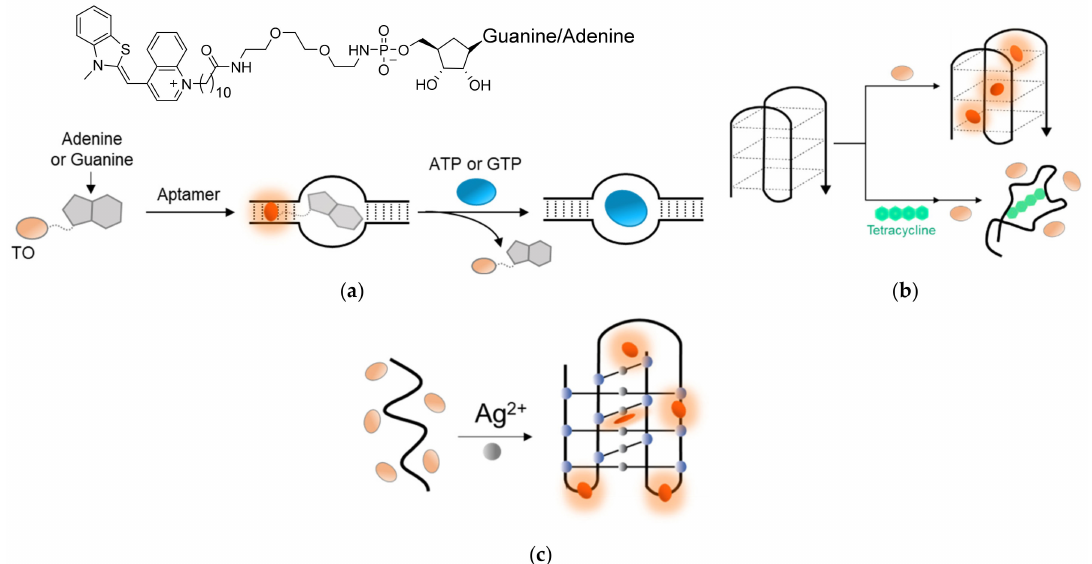
Figure 10. Sensing of ions and small molecules by coupled interactions of TO and nucleic acids. ( a ) The chemical structure of TO-AMP/GMP conjugates (top) that exhibit ‘turn-on’ fluorescence upon binding to ATP or GTP-specific RNA aptamers (bottom). ATP or GTP displace the conjugates from the aptamer, resulting in reduced fluorescence [136]; ( b ) Sensing of tetracycline by affinity changes towards TO resulting from conformational changes in its aptamer. When unbound to tetracycline, the aptamer adopts a G-quadruplex conformation with high affinity for TO. However, the binding of tetracycline yields a less structured conformation, thereby reducing the affinity of TO towards the aptamer and lowering its fluorescence [137]; ( c ) The binding of TO to an Ag 2+ -stabilized i-motif provides the means to detect Ag 2+ ions by monitoring the increase in TO’s fluorescence